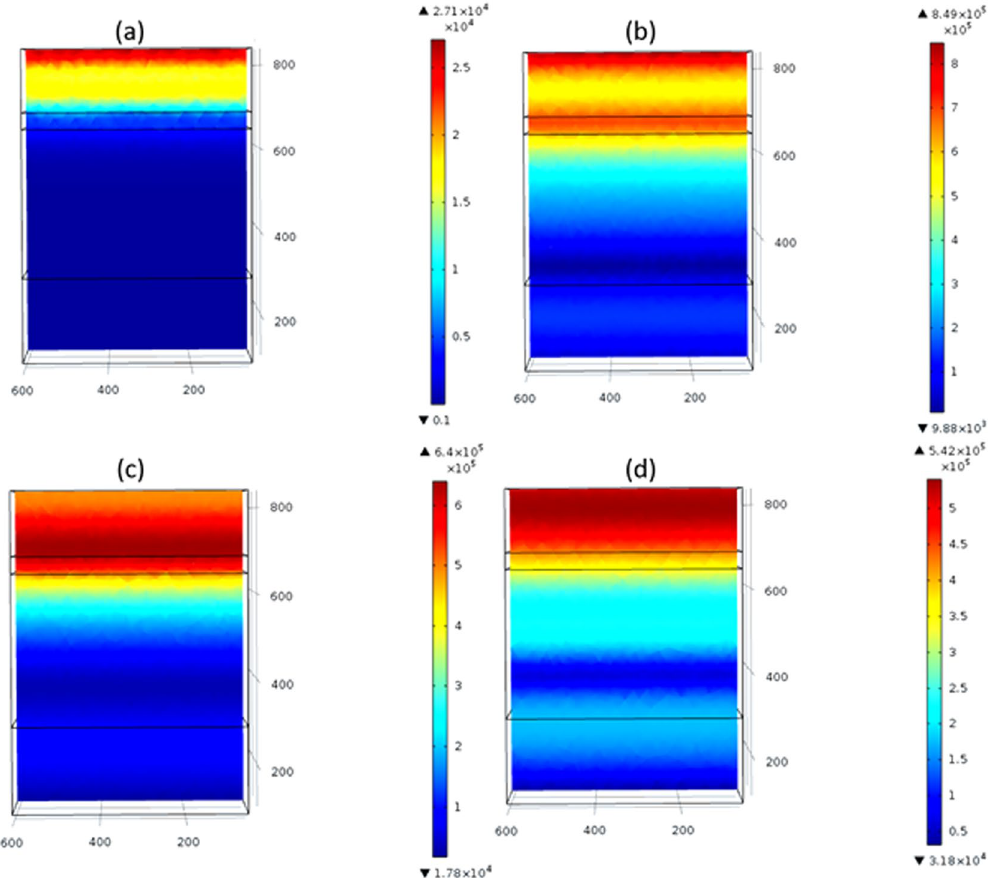
Figure 2. Electric field profiles at different wavelengths: ( a ) 300 nm, ( b ) 800 nm, ( c ) 1000 nm, and (d) 1200 nm for planar